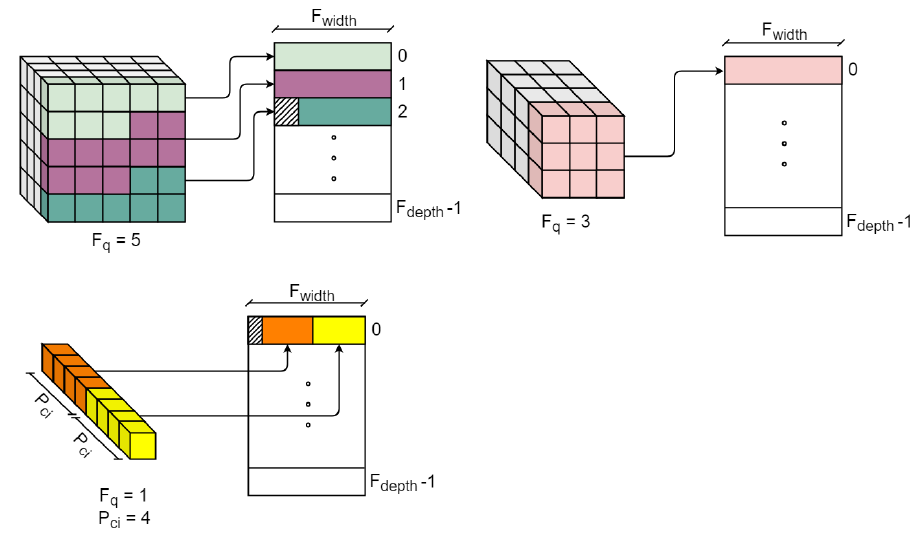
Figure 5. Filter Memory storage strategies.